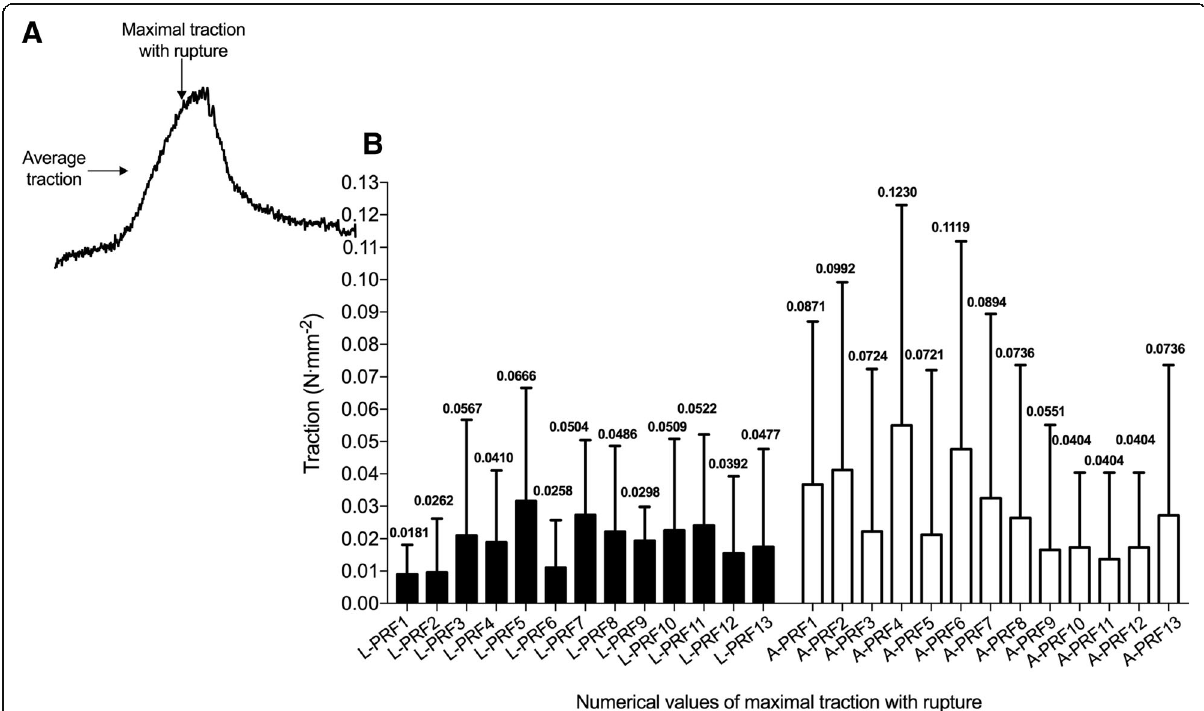
Fig. 4 Average and maximal traction values. a Representative traction profile with maximal traction with rupture of membrane and average traction identified by arrows. b Individual values of each membrane tested for each protocol with average values of traction, and maximal value for traction measured